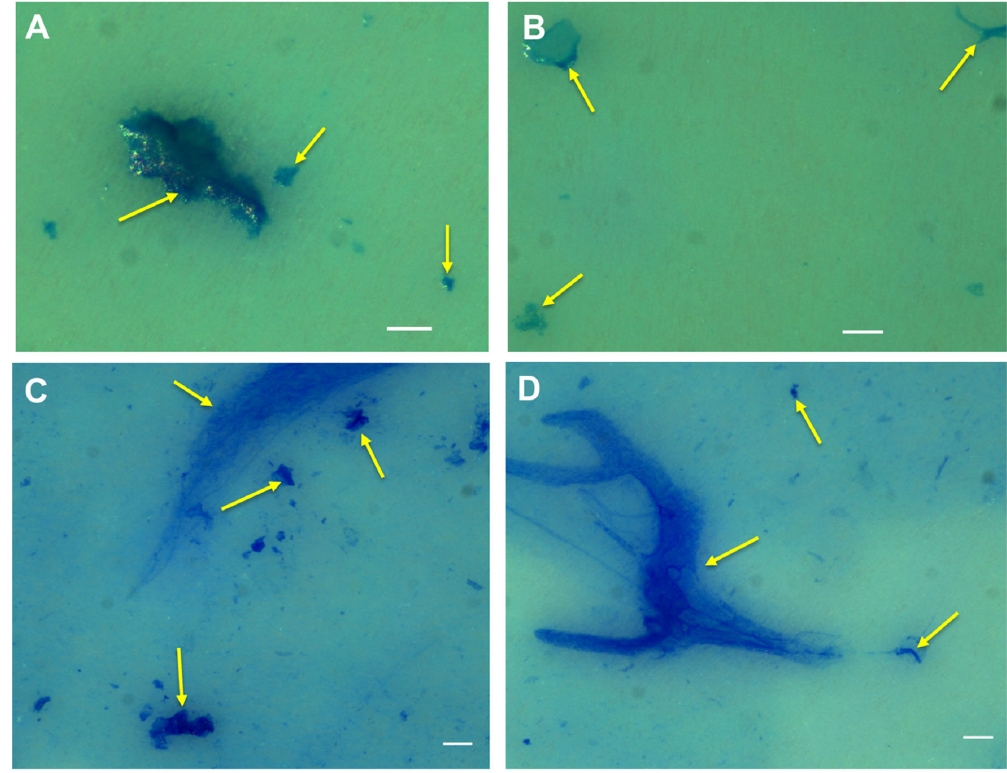
Figure 9. P. atlantica EPS stained with Alcian blue (( A , B ); yellow arrows) and Coomassie blue (( C , D ); yellow arrows). Images taken using an upright Leica microscope. Scale bar = 50 µm.